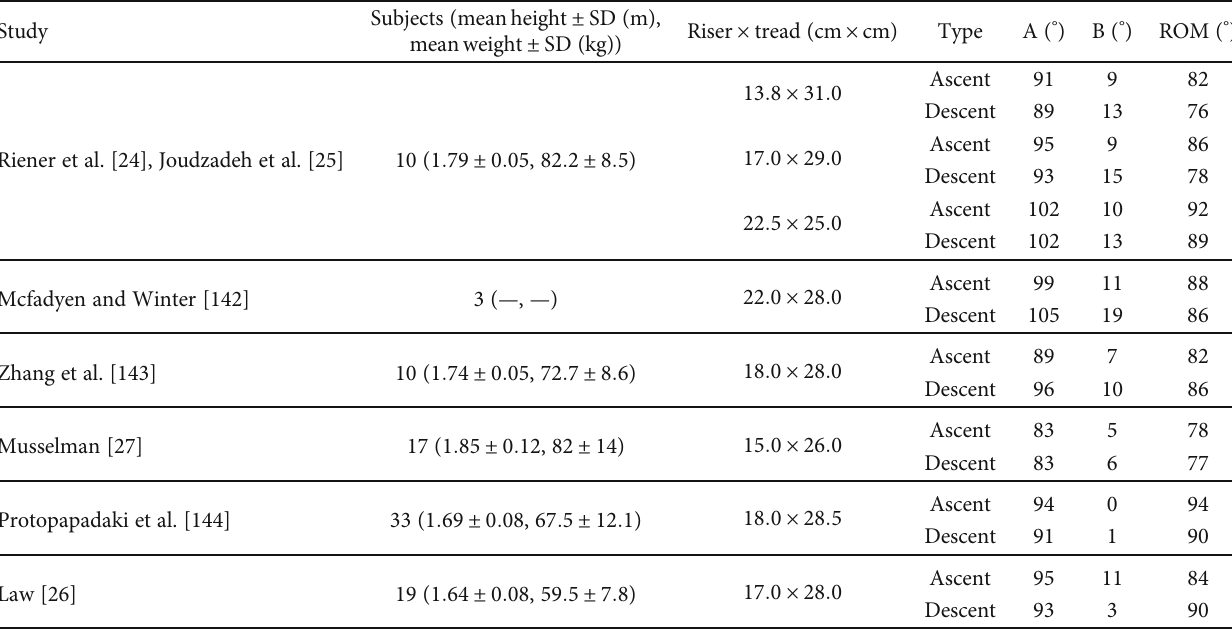
Figure 4: A sketch map of motion and the typical curves of knee angle, moment, and power in sagittal plane for stair ascent and stair descent. (a) Sketch map of the stair ascent and stair descent motion. (b) Knee angle-time curve ((A) peak knee fl exion angle and (B) peak knee extension angle. (c) Knee moment-time curve ((E) fi rst peak knee extension moment, (F) fi rst peak knee fl exion moment, (G) second peak knee extension moment, and (H) second peak knee fl exion moment). (d) Knee power-time curve ((I) fi rst peak knee generation power, (J) fi rst peak knee absorption power, (K) second peak knee generation power, and (L) second peak knee absorption power) [24, 25]. Table 7: Overview over the experimental results of knee angle for stair ascent and stair